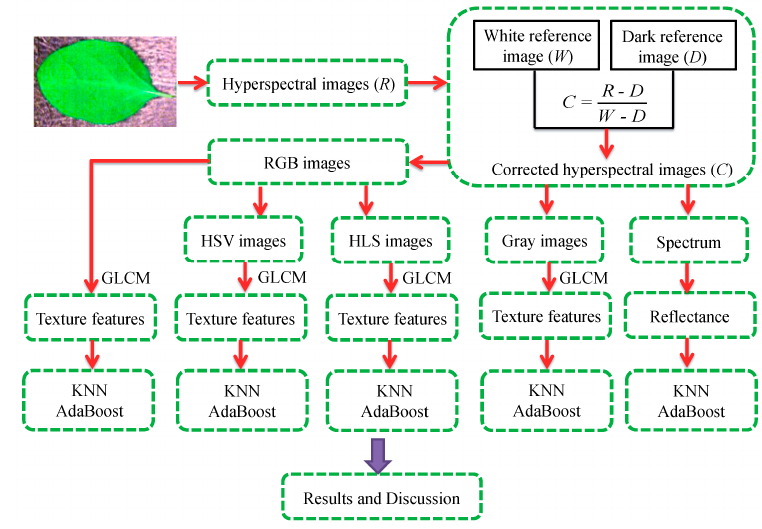
Figure 2. The flow diagram of this study.